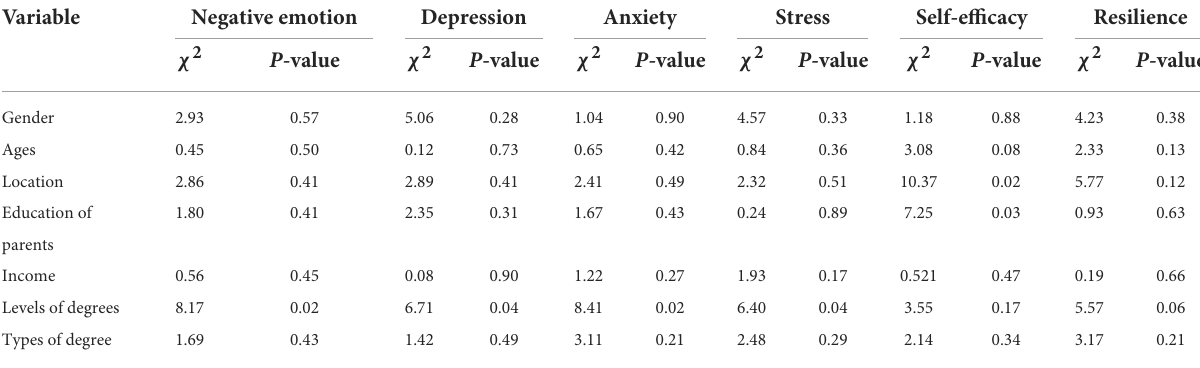
TABLE 3 The variables that possibly affect mental health among Chinese postgraduate students. Variable